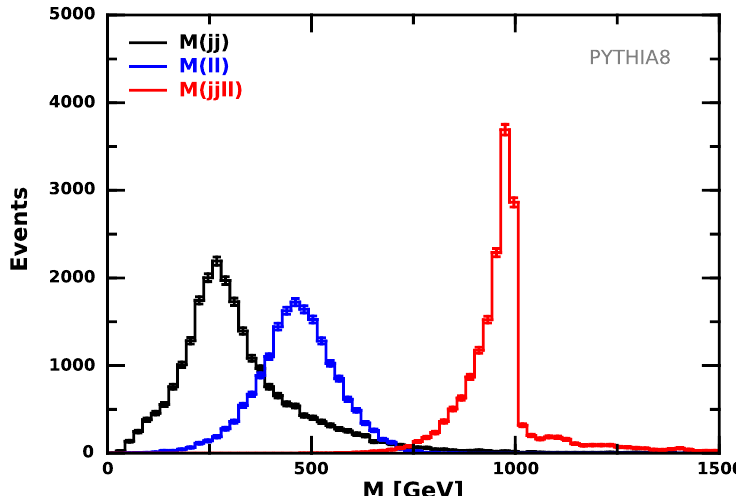
Figure 8. The invariant masses of two jets ( m jj ), two leptons ( m ll ) and two jets and two leptons ( m jjll ) in events A → B C simulated by PYTHIA 8 with the settings as described in the